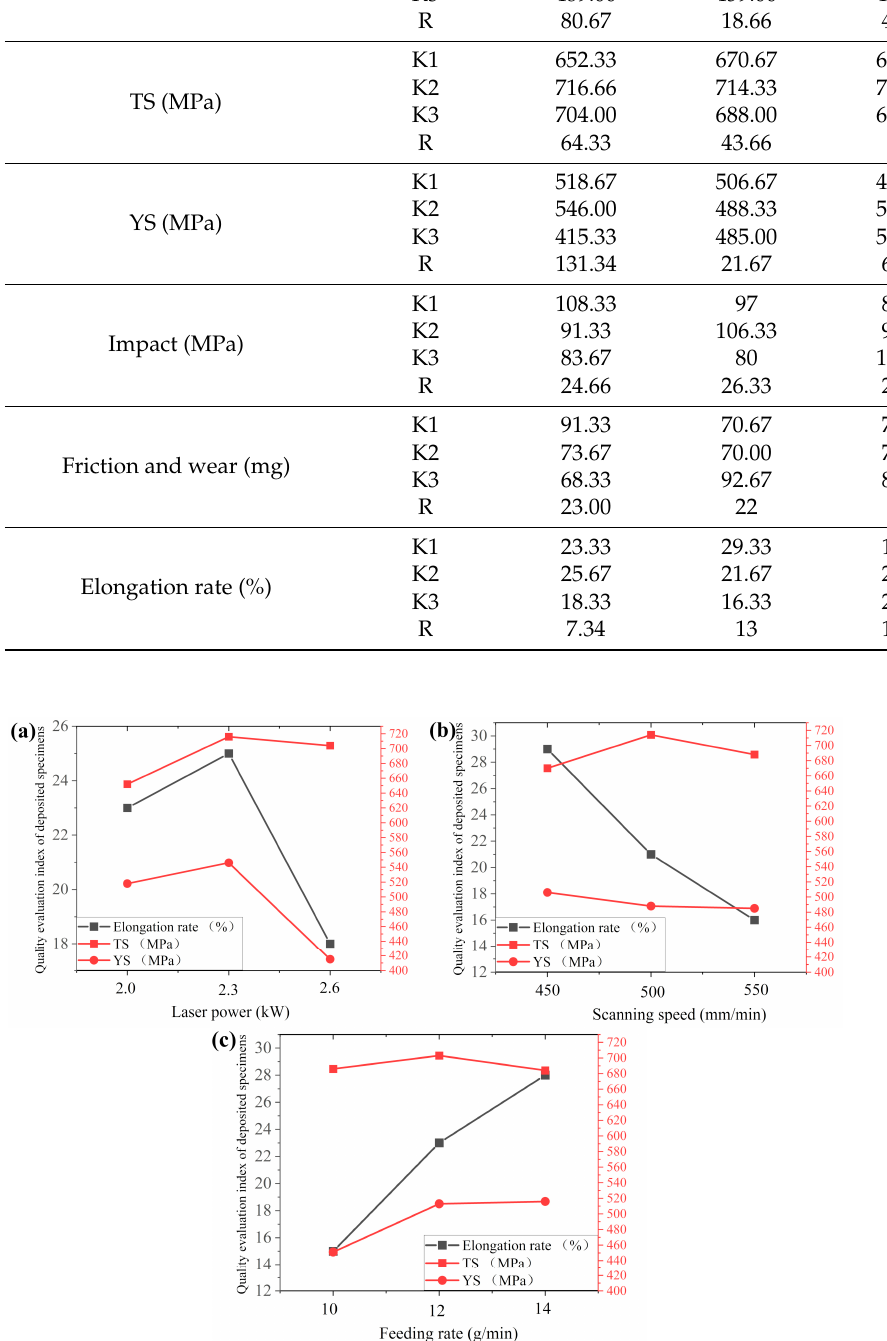
Figure 15. Range analysis: ( a ) variation of tensile properties with laser power; ( b ) variation of tensile properties with scanning speed; ( c ) variation of tensile properties with powder feeding rate.